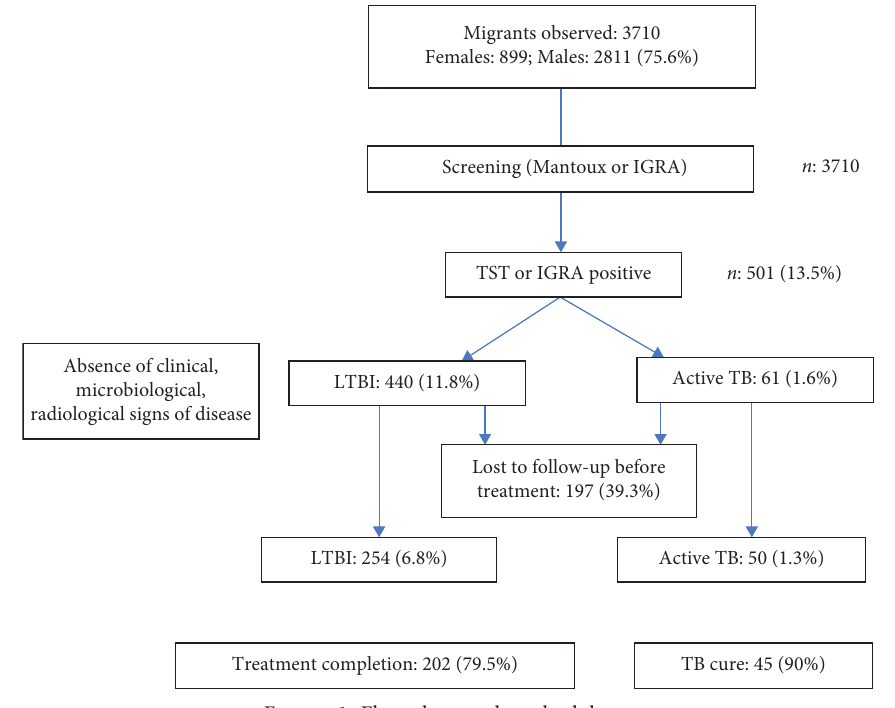
Figure 1: Flow chart and methodology.